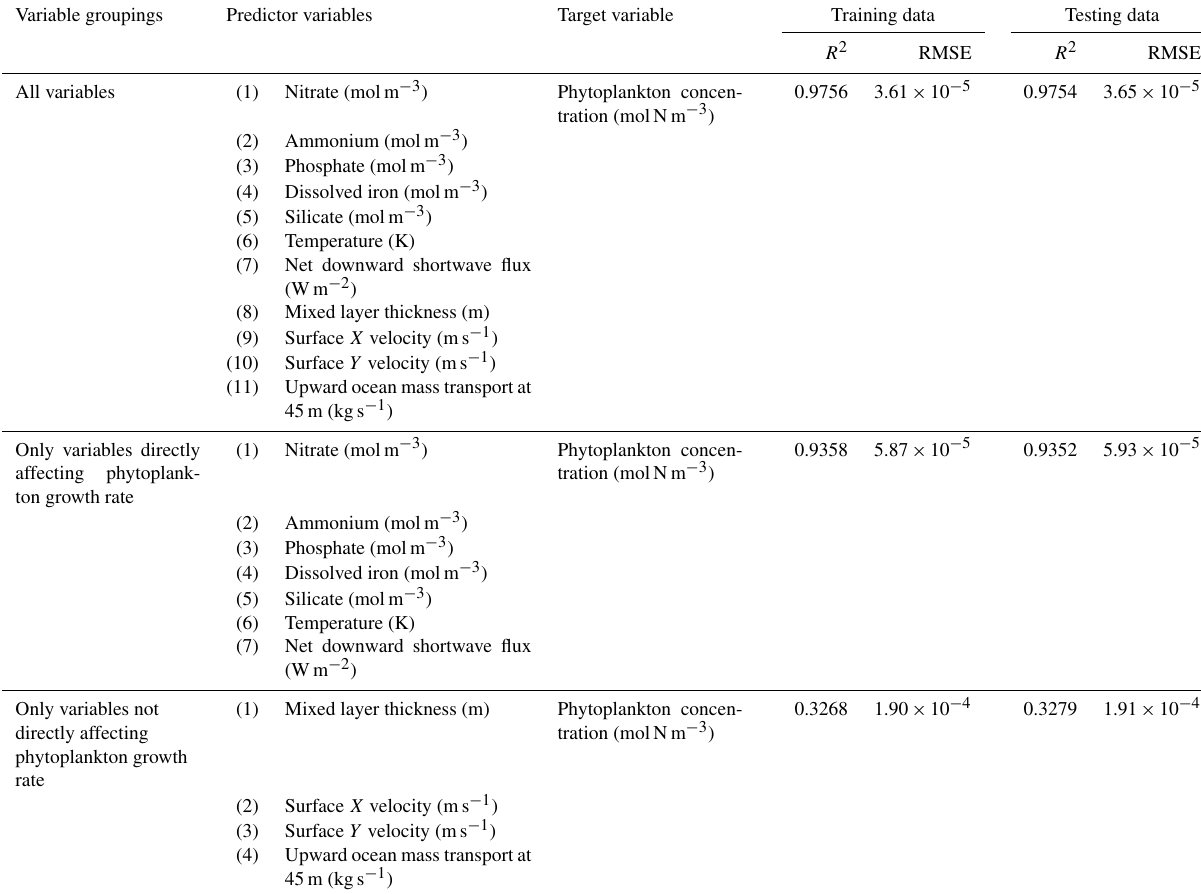
Table 6. The performance metrics for the training and testing subsets of NNEs trained on different variable combinations of CMIP5 ESM2M output and details about the predictor and target